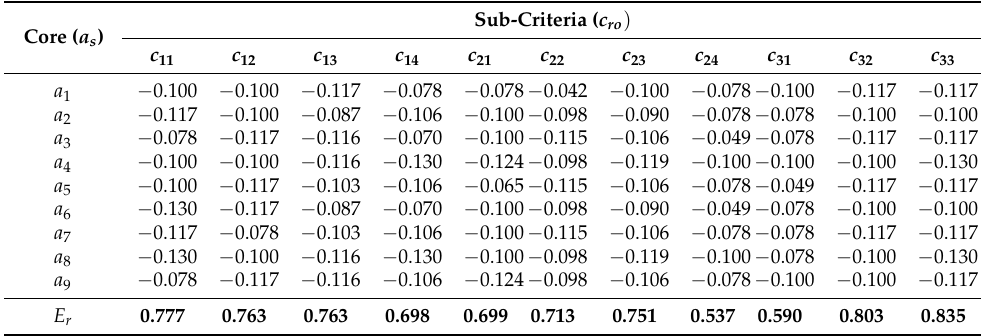
Table 14. The entropy values ( E r ) of each criterion for each incoming core. Core ( a s )